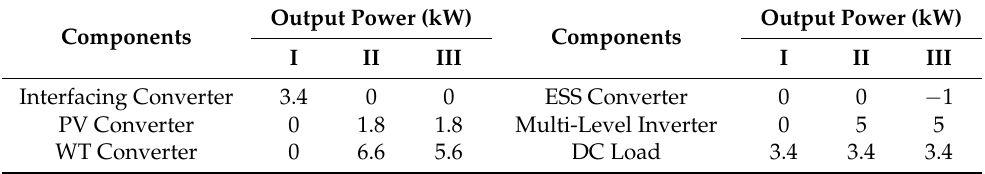
Figure 25. Experiment waveforms of PV converter and ESS converter in mode 4. Table 4. Output power of each power conversion devices in mode